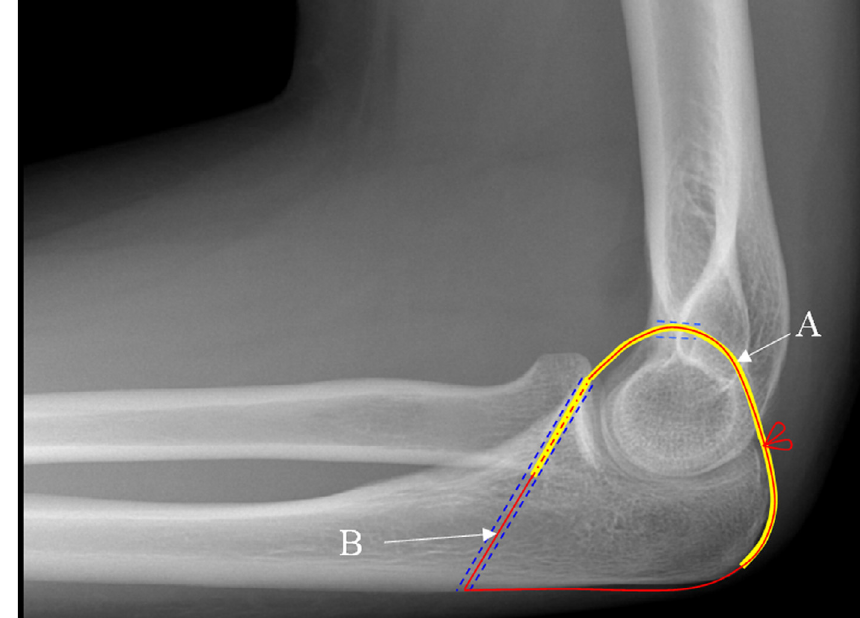
Figure 7. Diagram demonstrating modification of triceps tendon (A) reconstruction with extended suture (B).